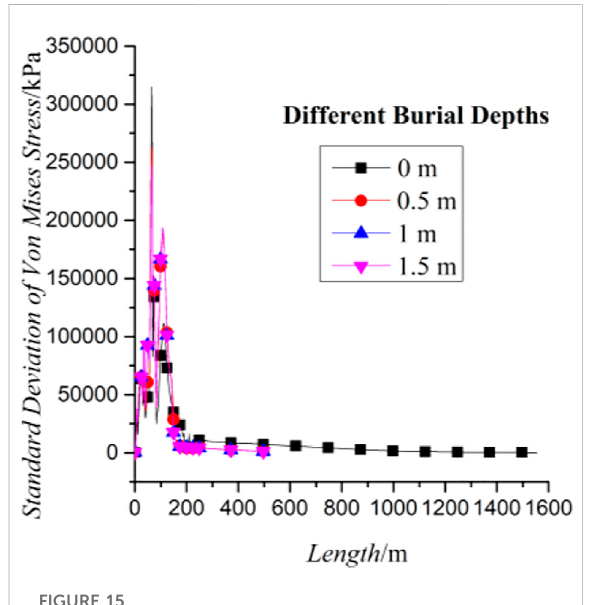
FIGURE 15 Standard deviation of Von Mises of the pipeline in the length direction with different burial